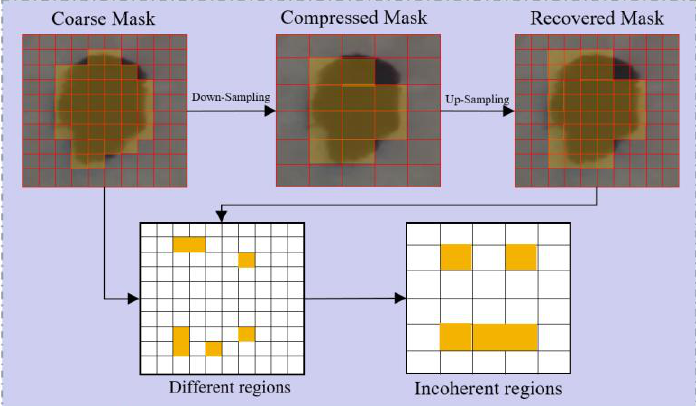
Figure 9. The definition of incoherent regions.